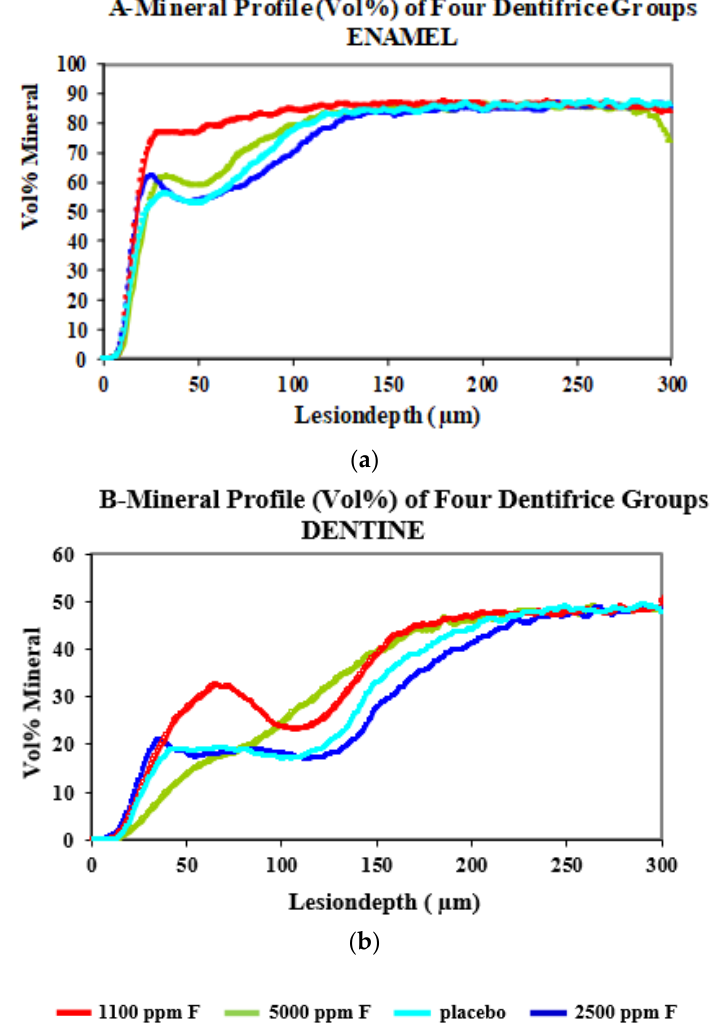
Figure 2. Mineral profiles (Vol%) of four dentifrices for enamel ( a ) and dentine ( b ). The X-axis shows the depth (micron meters).